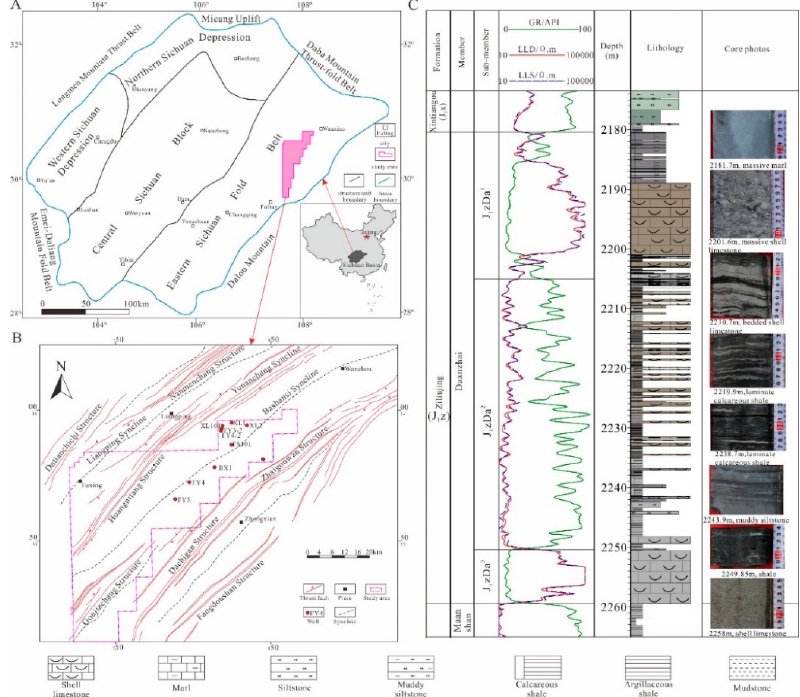
Figure 1. Study location ( A ), geological map ( B ), and simplified stratigraphic column ( C ) of the Jurassic Da’anzhai member in the Eastern Sichuan Basin.